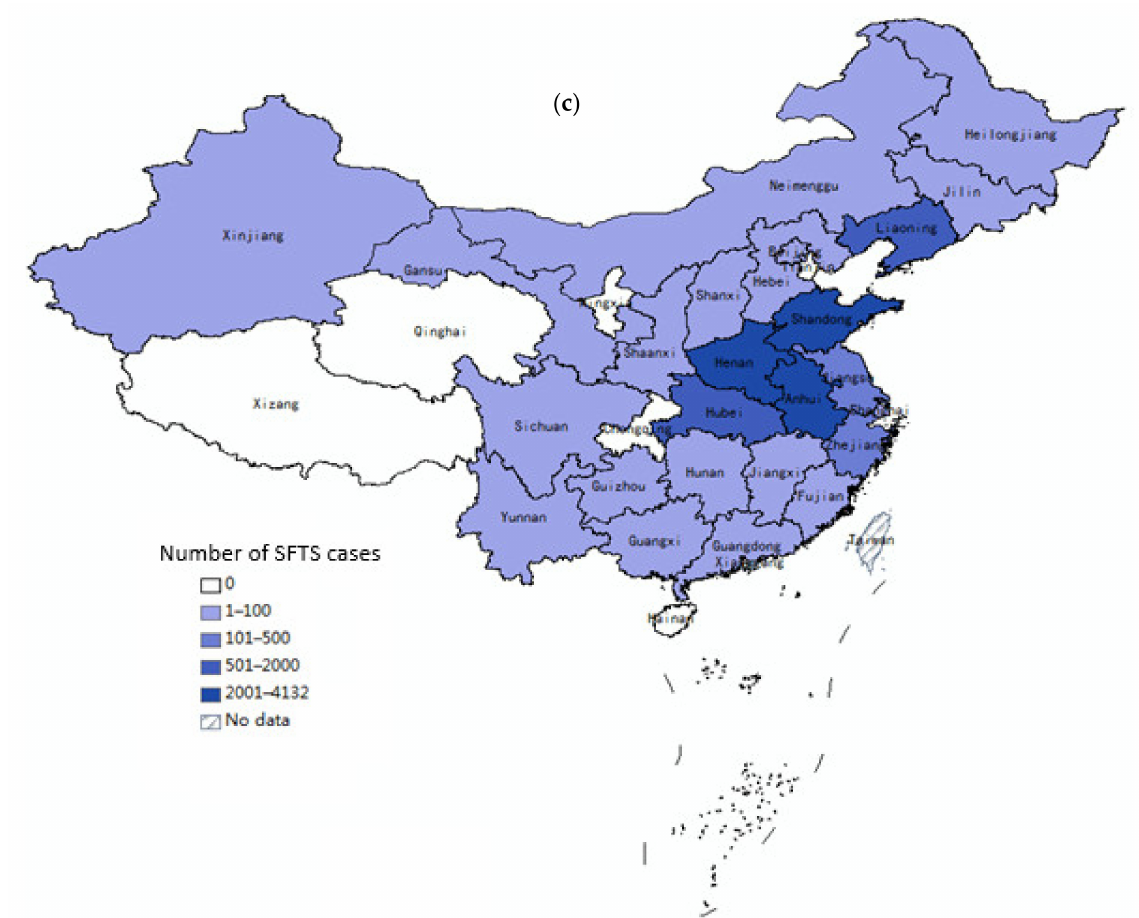
Figure 2. Regional distribution of SFTS cases in mainland China: ( a ) SFTS distribution in 2010, ( b ) the accumulative SFTS distribution from 2010 to 2014, and ( c ) the accumulative SFTS distribution from 2010 to 2019.